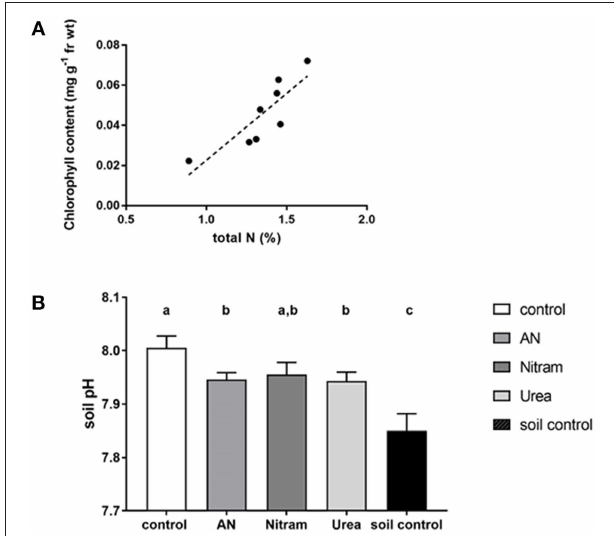
FIGURE 10 | (A) Linear regression analysis for %N and chlorophyll a + b. (linear regression R 2 = 0.717, p = 0.008, Pearson’s correlation coefficient = 0.847, n = 8, df: 1, 6, F = 15.19). (B) Soil pH measured at the end of 8 weeks using DS. An additional soil control (without plants) was included. Letters